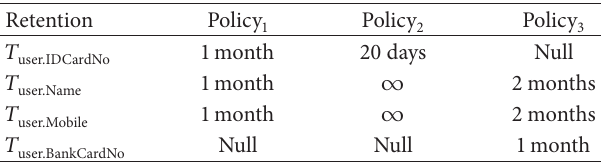
Table 7: Retention values of Data elements in FlightBooking, HotelReservation, and Payment services.